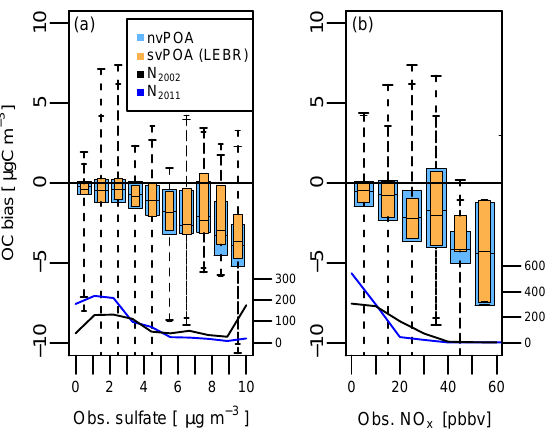
Figure 13. Organic carbon bias for CSN summer time data during 2002 and 2011 (combined) as a function of observed sulfate con- centrations (a) and observed NO x concentrations (b) . The meaning of boxes and whiskers is explained in Fig. 5. Blue (2011) and black (2002) solid lines quantify the number of data points for each year as functions of the observed